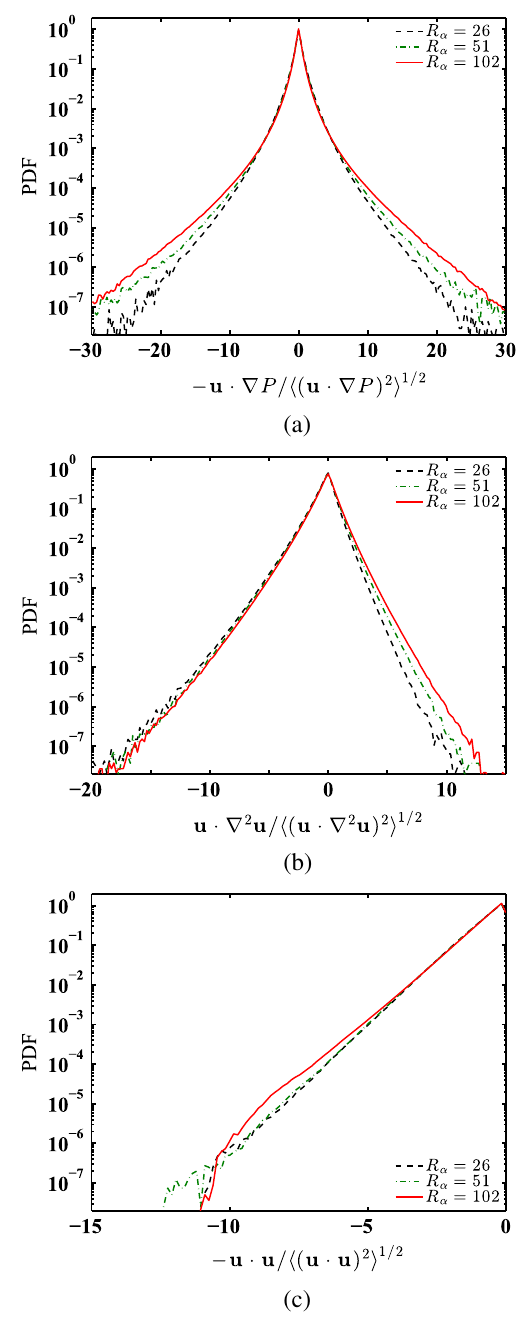
FIG. 5. PDFs of (a) the pressure term − u · ∇ P , (b) the viscous term ν u · ∇ 2 u , and (c) the friction term − α u 2 , normalized by their standard deviations, in 2D turbulence. The Reynolds numbers of the flows shown are R α ¼ 26 , 51, and 102. The PDFs of − u · ∇ P are slightly asymmetric, while the skewness of ν u · ∇ 2 u is much larger in magnitude, from ≈ − 2 . 0 at R to ≈ − 1 . 2 at R α ¼ 102 . The exponential tails seen in the PDFs of − α u 2 reflect the (approximately) Gaussian distribution of u . Both the flatness ( ≈ 6 ) and the skewness ( ≈ − 2 ) of the friction term are approximately constant over the range of Reynolds numbers